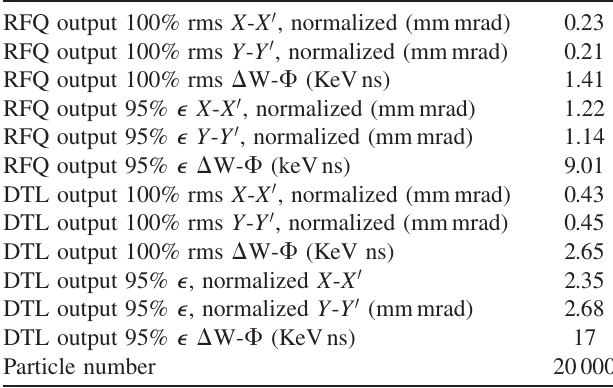
TABLE IV. Beam evolution of the FAIR proton injector